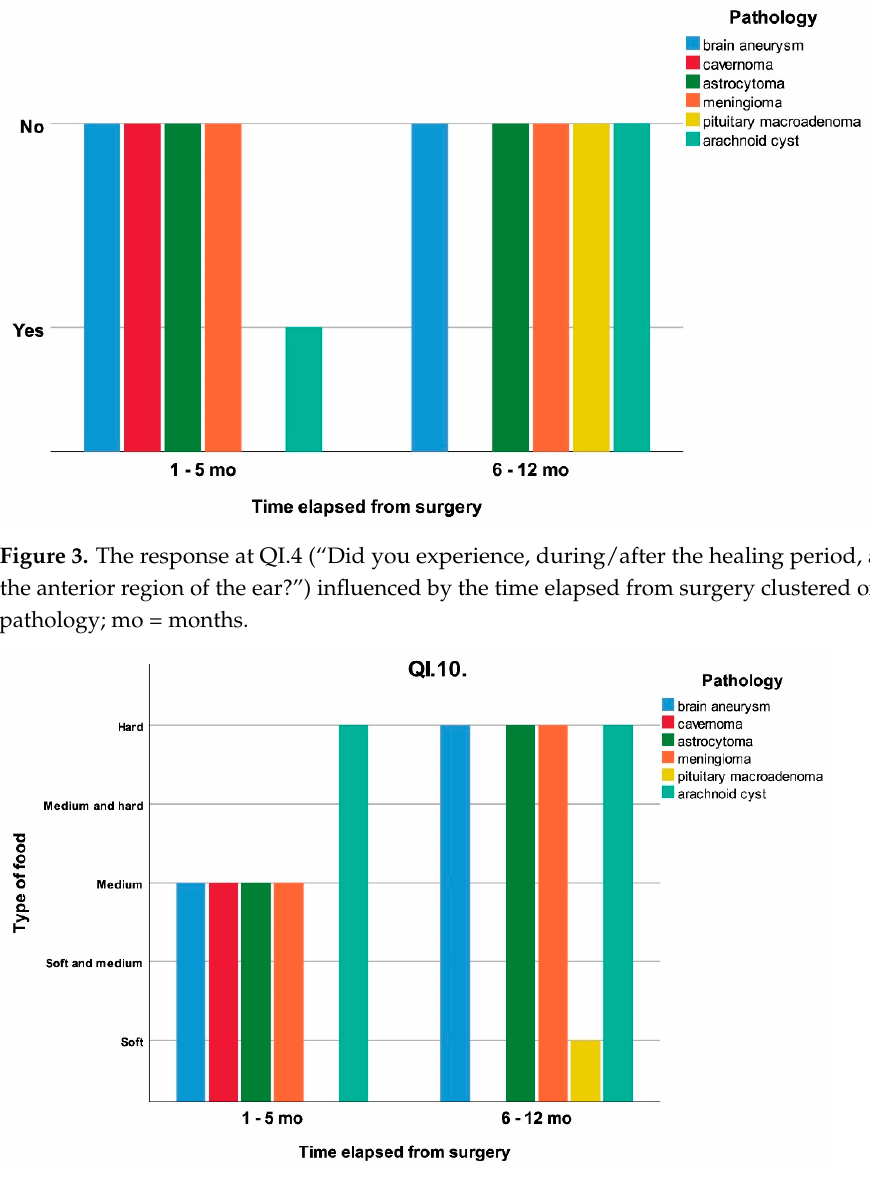
Figure 4. The response at QI.10 (“Please choose from the list what food could you chew without having pain on the affected side”) influenced by the time elapsed from surgery clustered on the initial pathology mo = months.